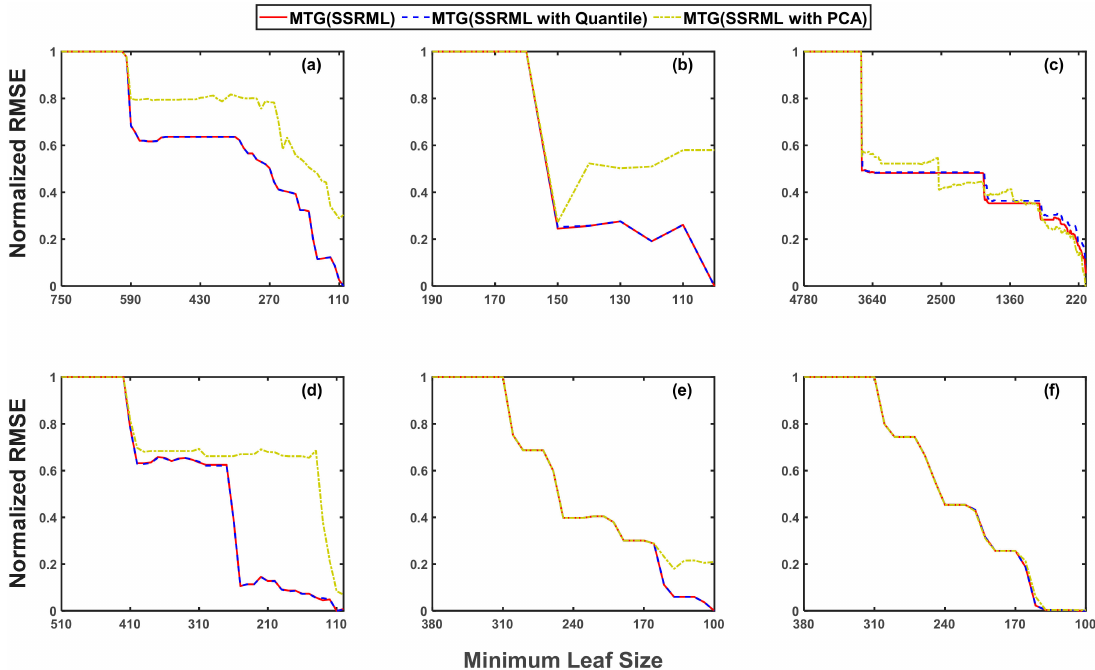
Figure 4. The normalized RMSE against minimum leaf size in descending order for; ( a ) airfoil self-noise, ( b ) auto MPG, ( c ) combined cycle power plant, ( d ) concrete compressive strength, ( e ) energy e ffi ciency (heating load) and ( f ) energy e ffi ciency (cooling